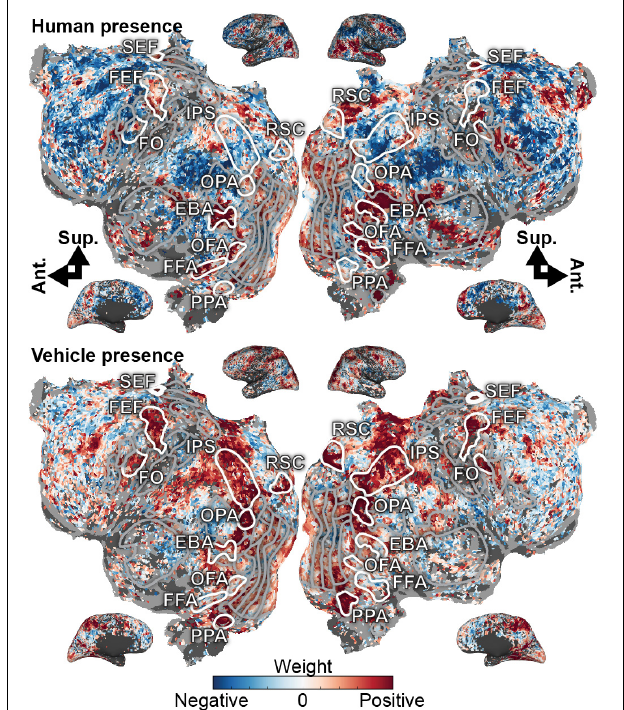
FIGURE 2 | Task variables in the visual attention task are represented in broad functionally specialized networks distributed across the cerebral cortex. Model weights for human- and vehicle-presence are shown on the flattened cortical surface for subject S1. Blue correspond to negative weights, white to no weights, and red to positive weights. Voxels are thresholded by the prediction performance of a semantic encoding model at a non-FDR-corrected p < 0.05 significance level. Selected ROIs are highlighted and labeled. Inflated cortices are shown for reference. The human presence axis is represented in FFA, OFA, and EBA, which are known to be activated by faces or body parts. Additionally, it is represented in MT, LO, SEF, and around the inferior frontal sulcus. The vehicle presence axis is represented in RSC, OPA, and PPA, all activated during spatial perception or navigation; in the IPS and FEF, both involved in spatial attention; and also in FO and inferior frontal sulcus. These model weights agree well with the known functions of the cortex and further suggest that task variables are meaningfully represented in a low-dimensional subspace of cortical